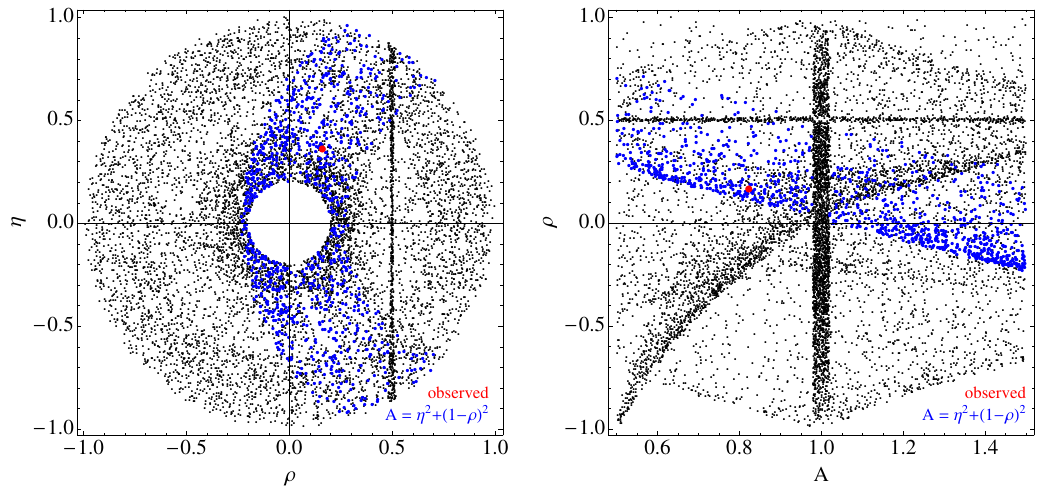
Figure 3 . The black dots show the ( η, ρ ) ( left ) and ( A, ρ ) ( right ) of 10 4 CKM matrices generated with Wolfenstein Anarchy that satisfy at least 1 simple relation, eq. (3.3) with precision δ = 0 . 02 . For this scan we fix λ = 0 . 225 . We find that 13% of random CKM matrices satisfy at least one relation. The blue dots correspond to random CKM matrices that satisfy relation R 1 , A = η 2 + (1 − ρ ) 2 . The red dot is the observed CKM matrix. Several structures that are clearly visible in the plot correspond to relations that appear in table 1, such as A = 1 and ρ = 1 / 2